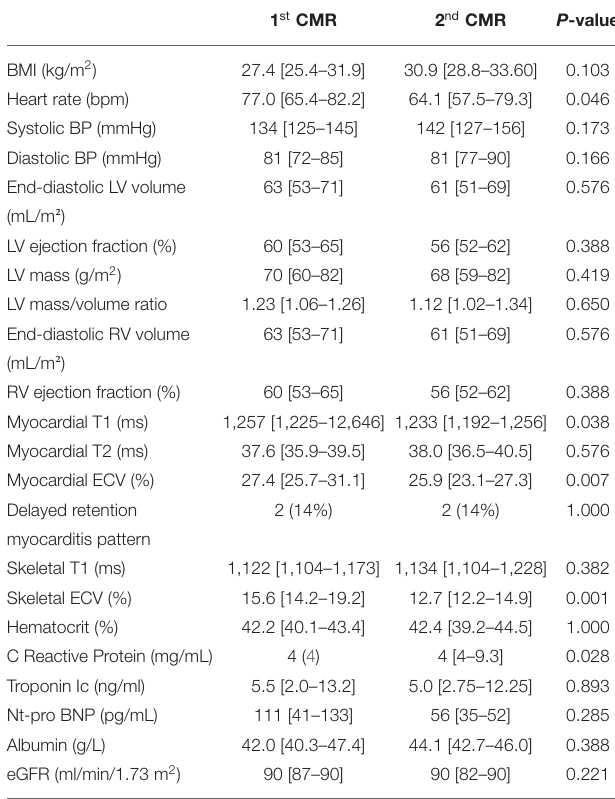
TABLE 3 | Changes in clinical, CMR and blood parameters of the 13 patients who underwent the two CMRs at medians of 3 and 11 months from peak troponin